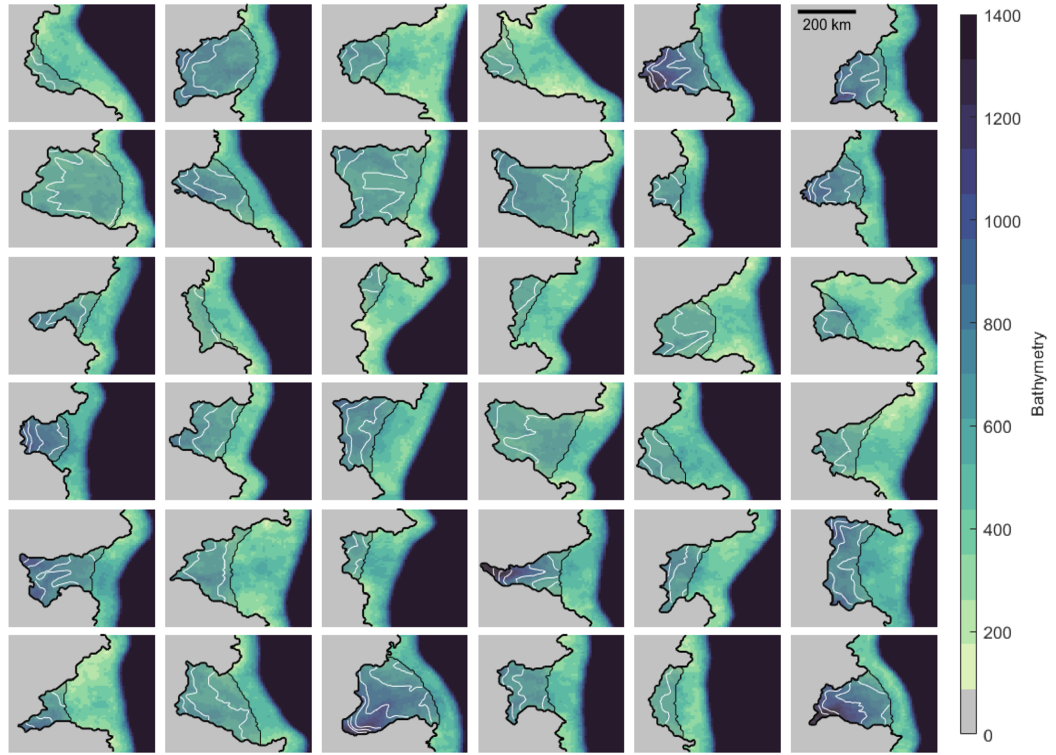
Figure 2. Sample of synthetic geometries produced using the algorithm outlined in Sect. 2.3.1. Grey delineates grounded ice, and the colour map represents seafloor bathymetry. White lines show ice-shelf draft, contoured from 200 to 800m at 100 intervals, and black lines show the outline of the ice sheet and ice-shelf